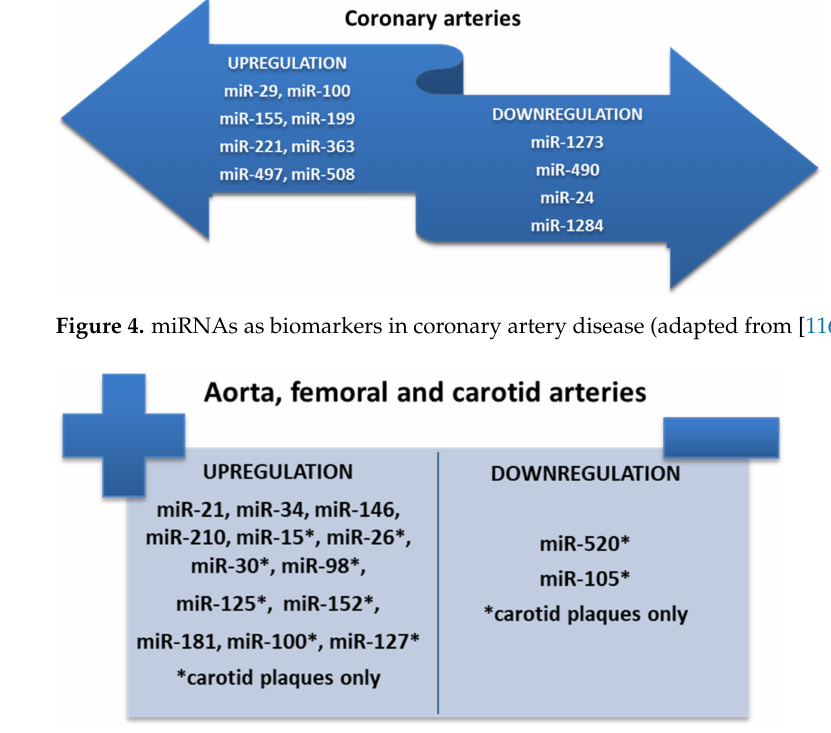
Figure 5. miRNAs as biomarkers in peripheral artery disease (adapted from